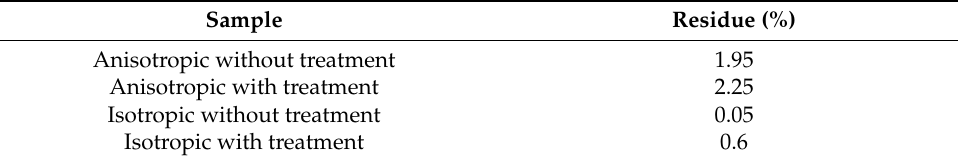
Table 1. Residual mass of MRE